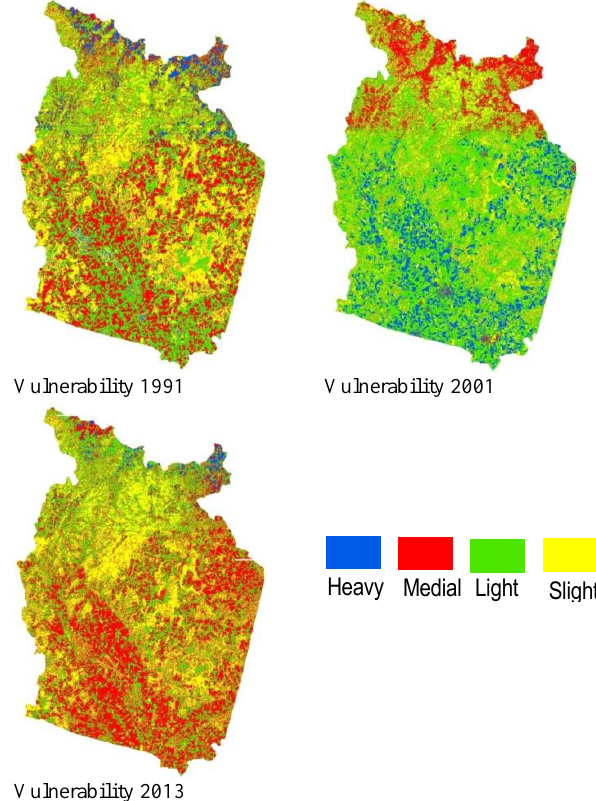
Figure 4. Environmental vulnerability maps of the study